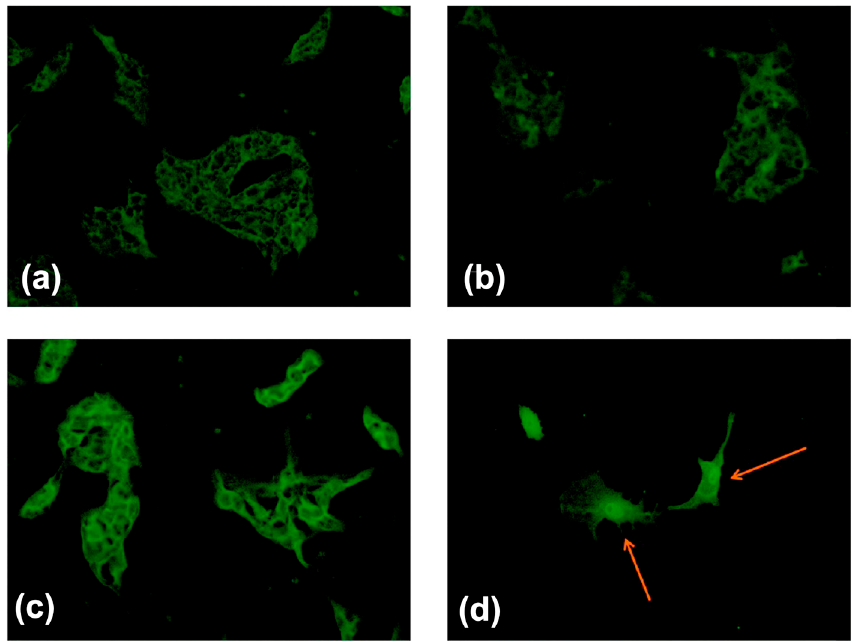
Figure 5. Immunofluorescence analysis of the apoptotic enzyme caspase-3 in B16 cells: ( a ) control cells; ( b ) cells exposed to the magnetic field; ( c ) cells treated with HFt; and ( d ) cells treated with HFt and exposed to the magnetic field. The alternating magnetic field of amplitude H 0 = 17.0 kA / m and frequency f = 183 kHz was applied for 30 min. Reprinted with permission from Ref 46 Copyright 2014 American Chemical Society.